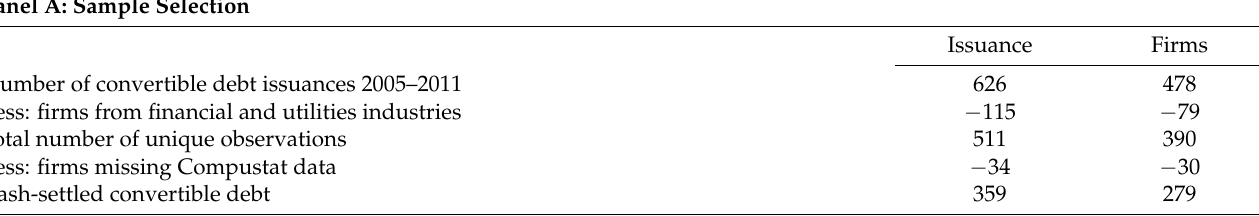
Table 1. Sample selection and industry